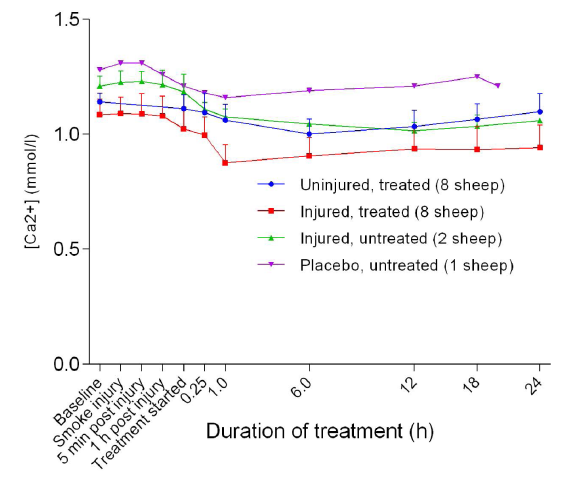
Figure 14. Concentration of calcium ions in blood (Mean ± SD) in smoke and non-smoke injured sheep that received extracorporeal life support as compared to that in untreated